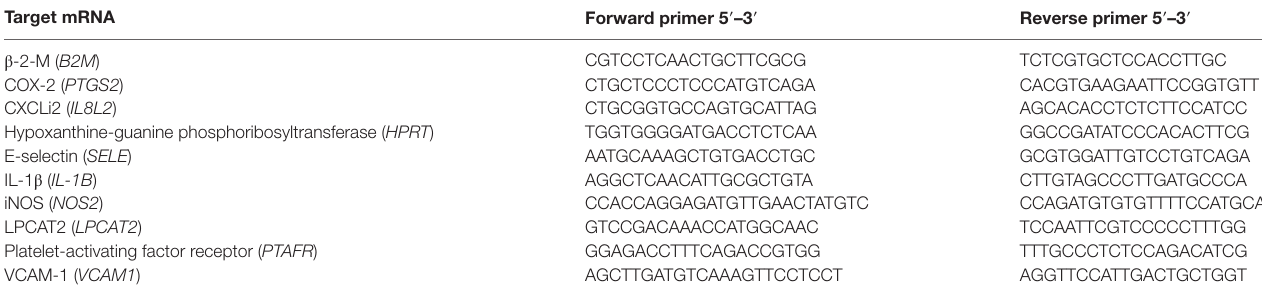
Table 1 | Primer pairs used in the present study for quantitative real-time PCR analysis. Target